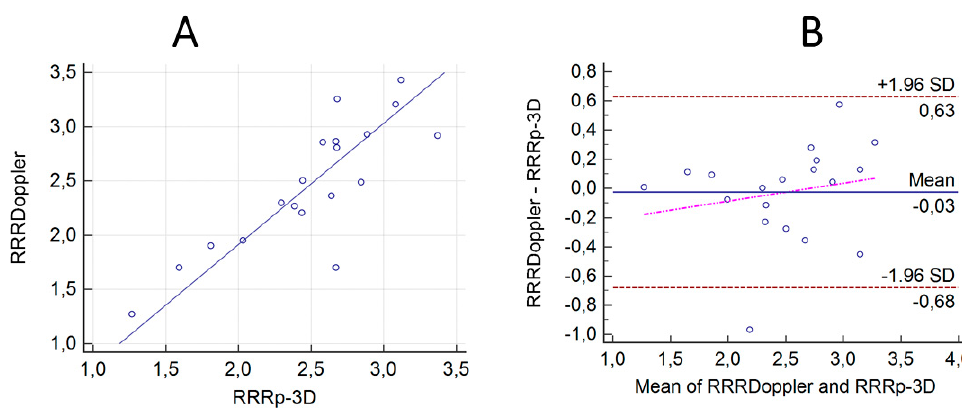
Figure 5. Correlation and agreement between the results of the ComboWire-based RRR measurements (RRR Doppler ) and the calculated RRR p-3D values with the correction for hydrostatic offset. ( A ) The calculated microvascular resistance reserve RRR p-3D corrected to the hydrostatic pressure error demonstrated a good correlation with the measured MRR Doppler values ( r = 0.83, p < 0.0001). ( B ) The Bland-Altman analysis showed the mean differences between the Doppler-measured and the calculated RRR p-3D values with hydrostatic offset correction to be − 0.03 ( ± 1.96 SD: 0.71, − 0.78).